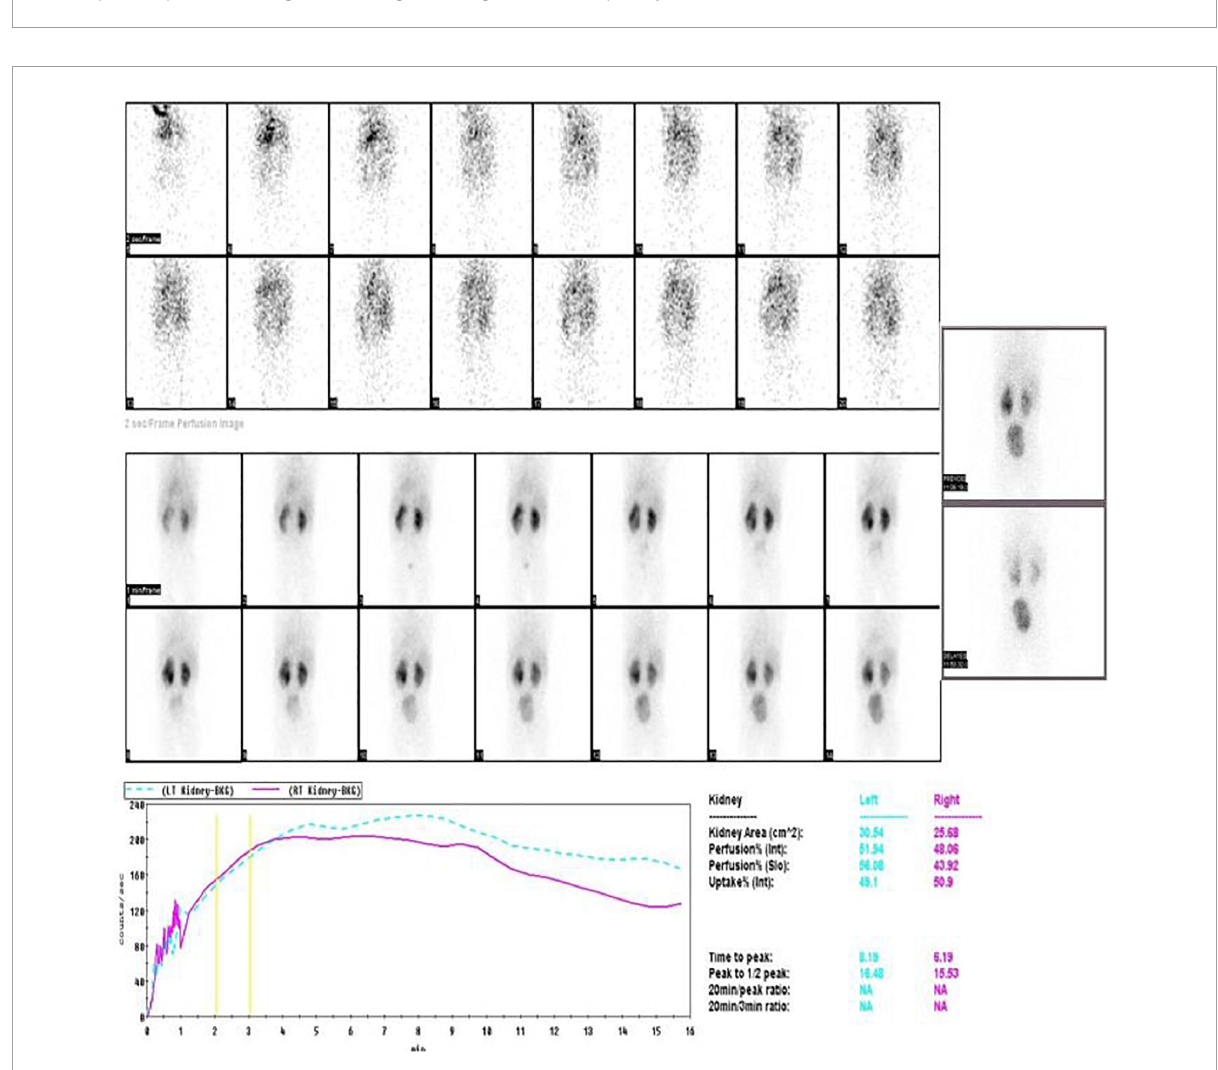
FIGURE4 Post-operative EC scan after 3 months showing resolution of hydronephrosis, improvement in drainage, and DRF of